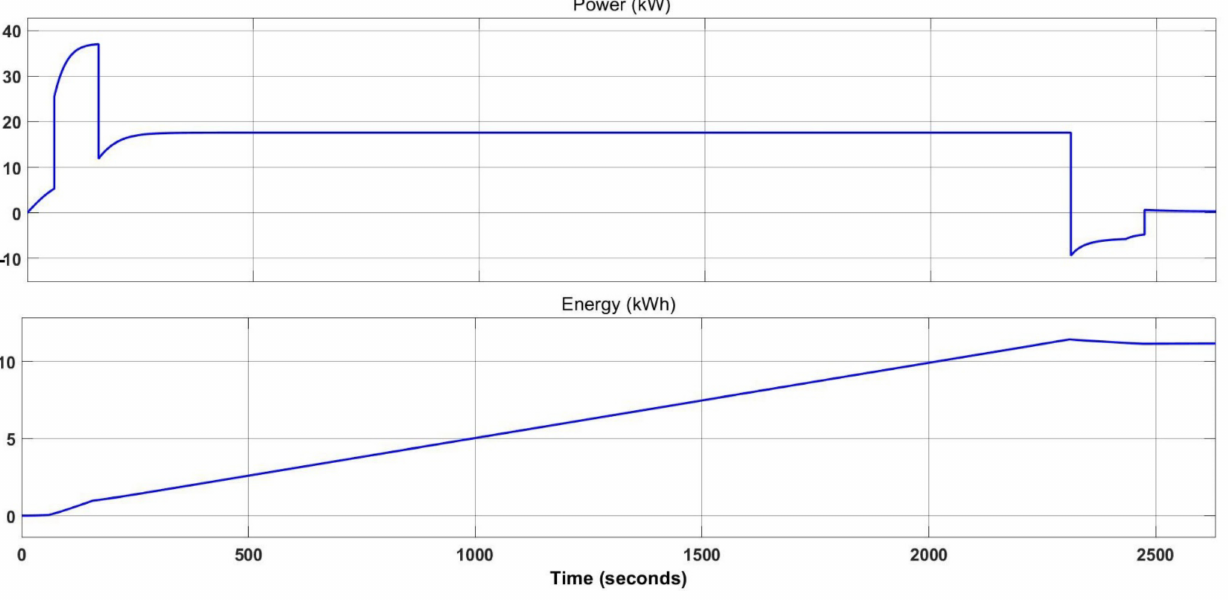
Figure 7. Power demand and energy consumption of electric WT-9 Dynamic—cross country